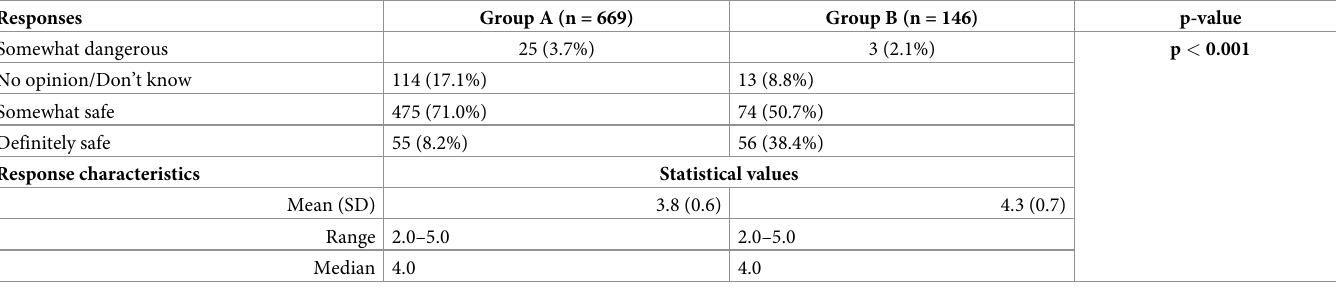
Table 1. Responses of the Polish (group A) and American (group B) nurses to the question: “How do you rate the safety of medicinal products being used?”.